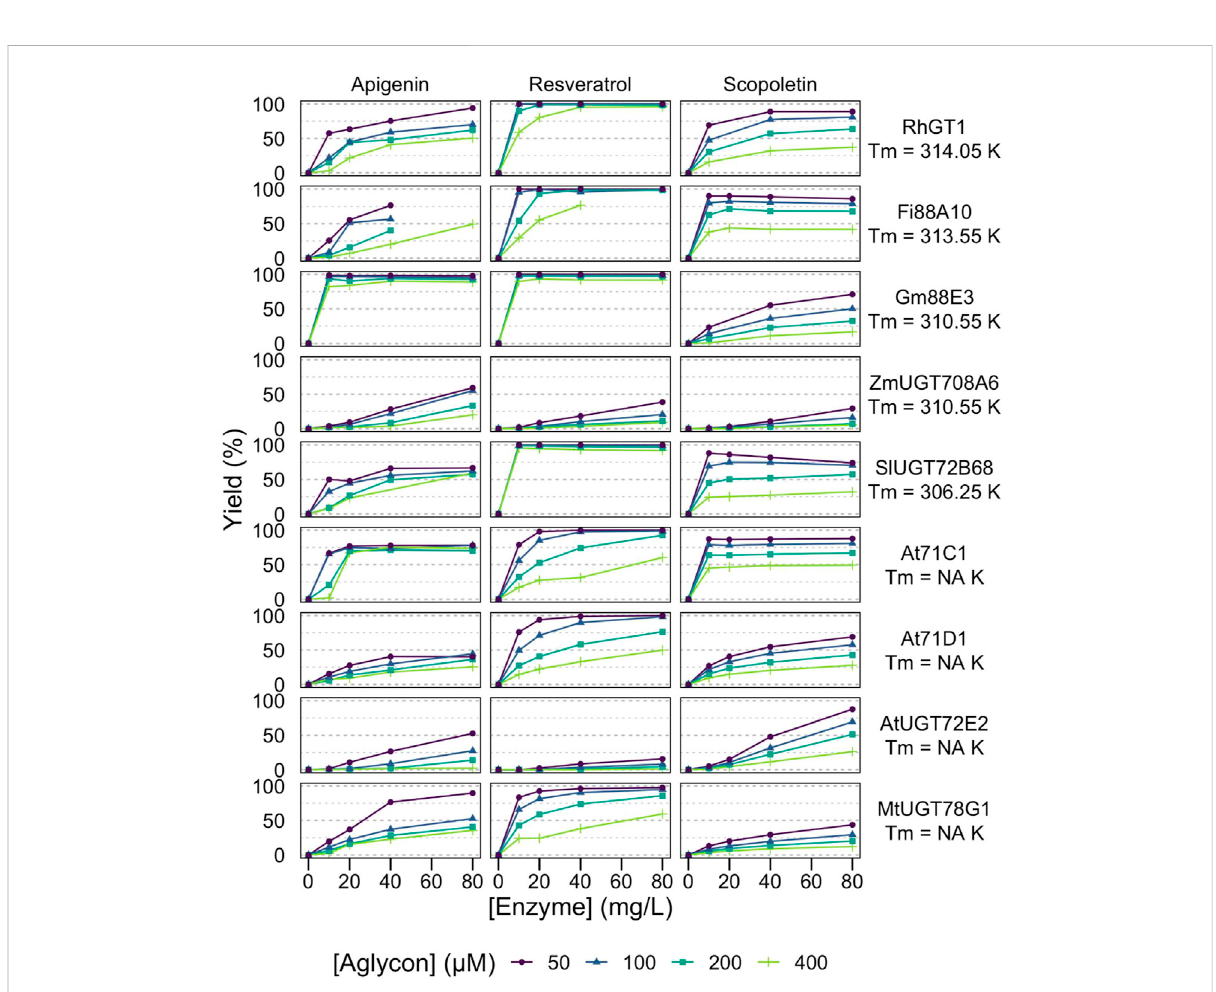
FIGURE 2 Effect of reaction conditions on glycosylation yields from low- T m enzymes. Analytic yields of acceptor conversion are plotted against enzyme concentration, from 10 to 80 mg/L (circa 0.15 – 1.2 μ M). HEPES pH 7, aglycon concentration range 50 – 400 μ M, UDP-Glc 500 μ M, 20 h at 293 K, without stirring in 100 μ l volume. The 9 GT1s with the lowest T m or no measured T m are displayed. NA = Not Available, as the fl uorescence as a function of the temperature did not re fl ect a classical behavior melting